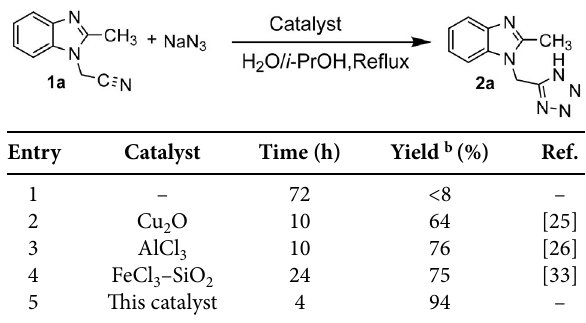
Table 3. Comparing the catalytic potency of SiO 2 -Cu- BDACDABSBC with various catalysts. a